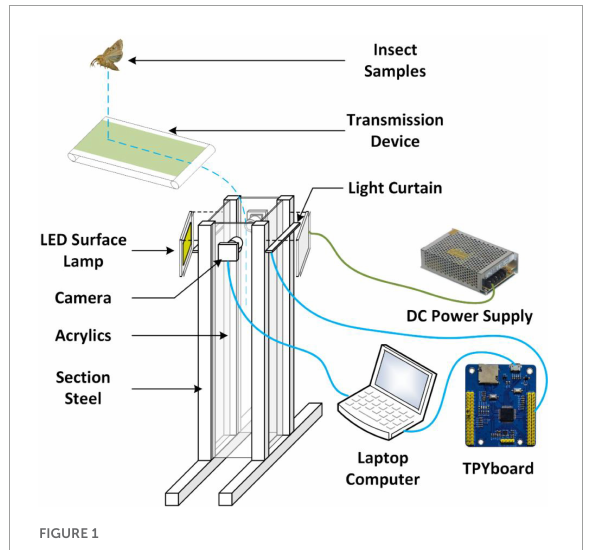
FIGURE1 Insect image acquisition